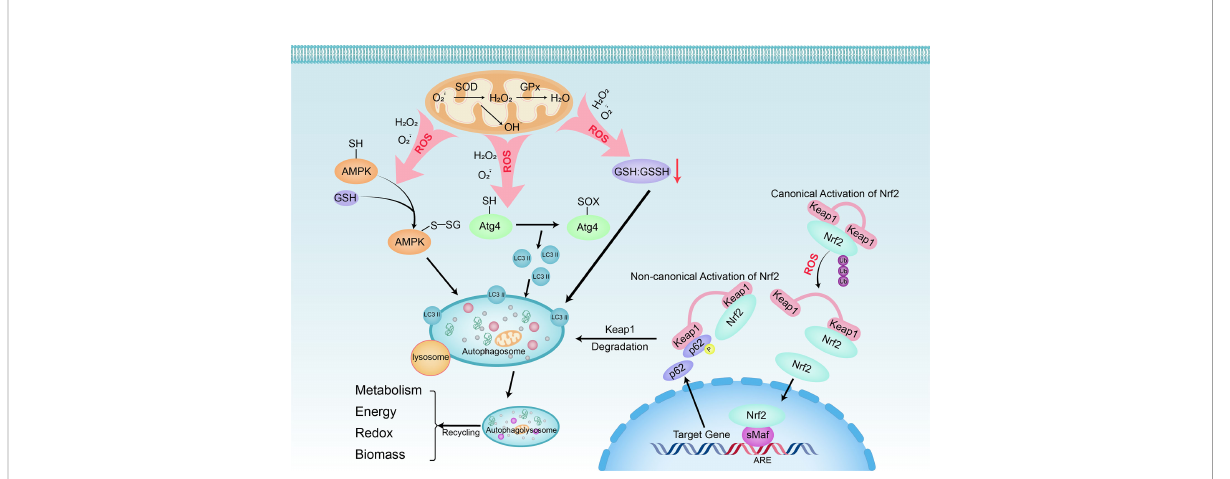
FIGURE 3 Linking oxidative stress to autophagy in HCC cells. Oxidative stress can be triggered by any dangerous or in fl ammatory signal and affects many cells in the liver. Superoxide (O2 − ) and H2O2 are the main ROS produced by mitochondria during nutrient deprivation. Three main regulatory pathways are involved the positive regulation of autophagy by ROS: 1) S-glutathionylation of cysteine located in the a and b subunits of AMPK (SH ! S-SG); 2) The oxidation of Cys81 (SH ! Sox) of Atg4 leads to the accumulation of LC3 II; 3) decrease of GSH : GSSH ratio. Furthermore, with oxidative and electrophilic stress, the oxidation of cysteine residues regulated by Keap1 will inhibit the ubiquitination of Keap1 and Nrf2, resulting in canonical Nrf2 activation and induction of target gene expression. When p62 is phosphorylated at Ser349, it binds to Keap1, causing its autophagy degradation. After that, Nrf2 freely transfers to the nucleus and induces target gene expression (non-canonical Nrf2 activation). When autophagosomes fuse with lysosomes that provide hydrolytic enzymes, the cargo is degraded. The breakdown products of autophagy are released into the cytoplasm, where they are recycled into metabolic and biosynthetic